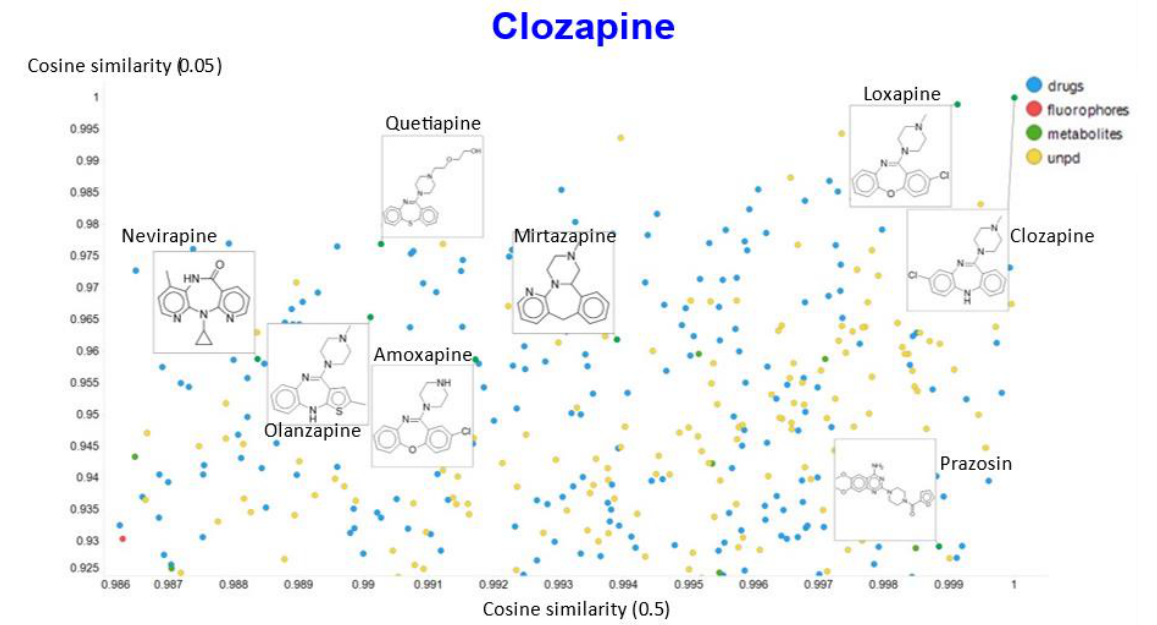
Figure 13. Relationship between cosine similarity for values of the temperature parameter of 0.05 and 0.5 for clozapine in our chemical space.